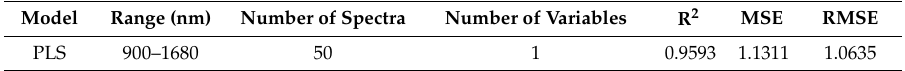
Table 2. Example results of determinations of cellulose content in buckwheat straw samples based on the obtained PLS calibration model.